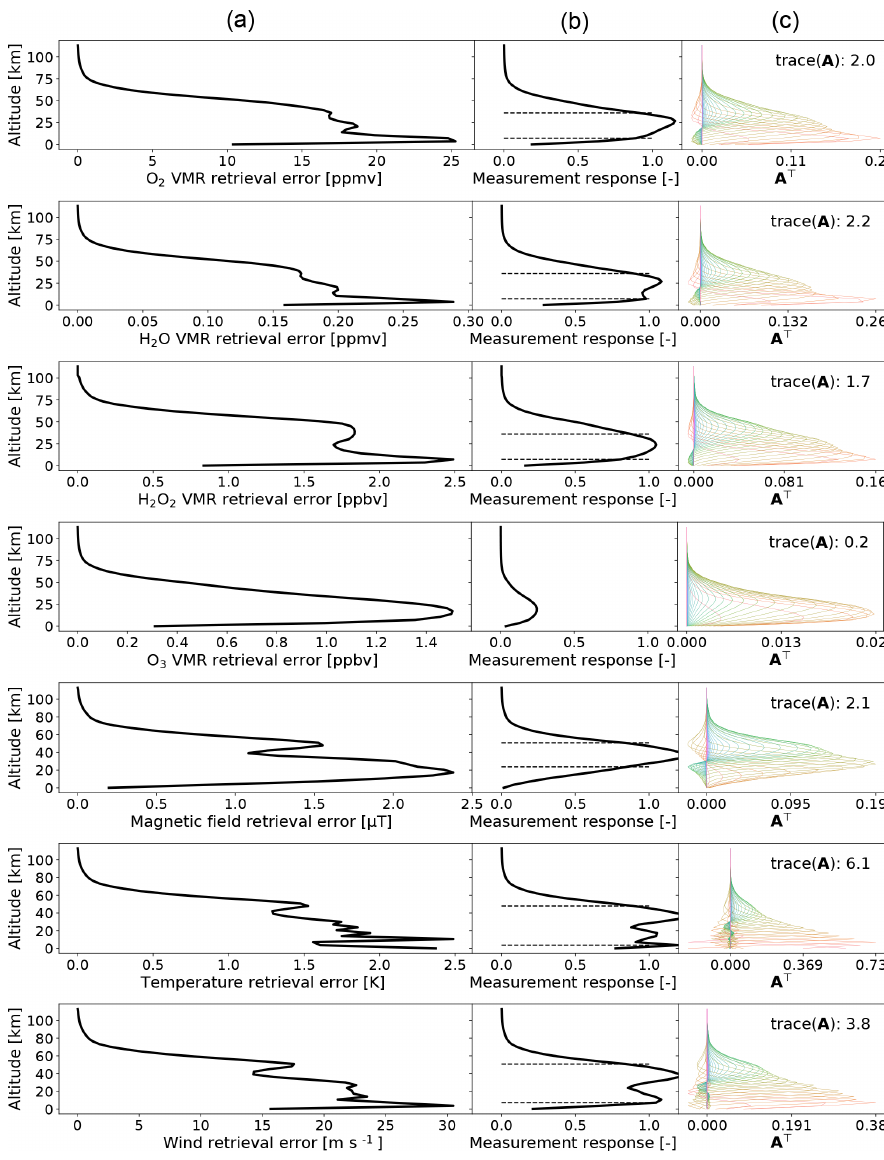
Figure 7. Same as Fig. 5 but for nadir-staring mode and for 1h of integration